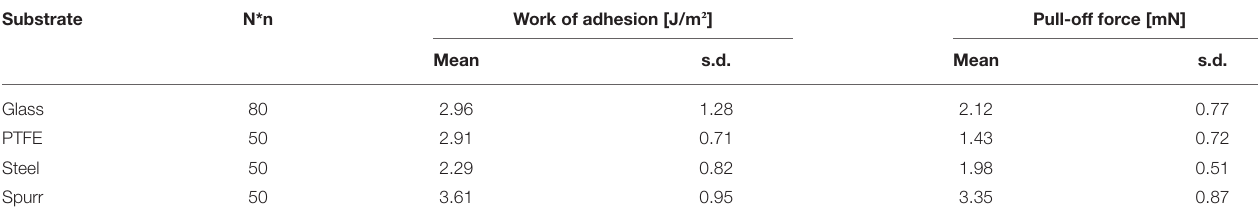
TABLE 3 | Propolis adhesion on different substrates.